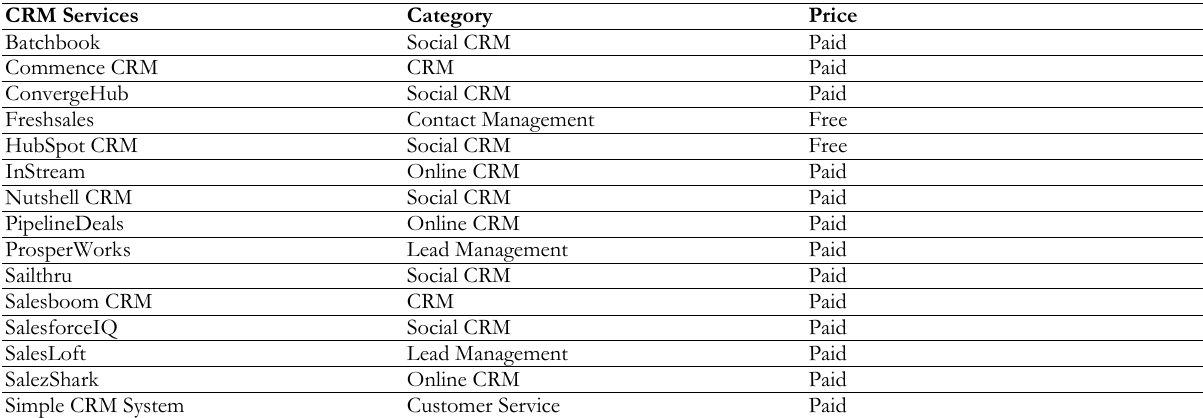
Figure 2. Differences between CRM and Social CRM (Source: Sexton, 2012) Table 1. Social Media